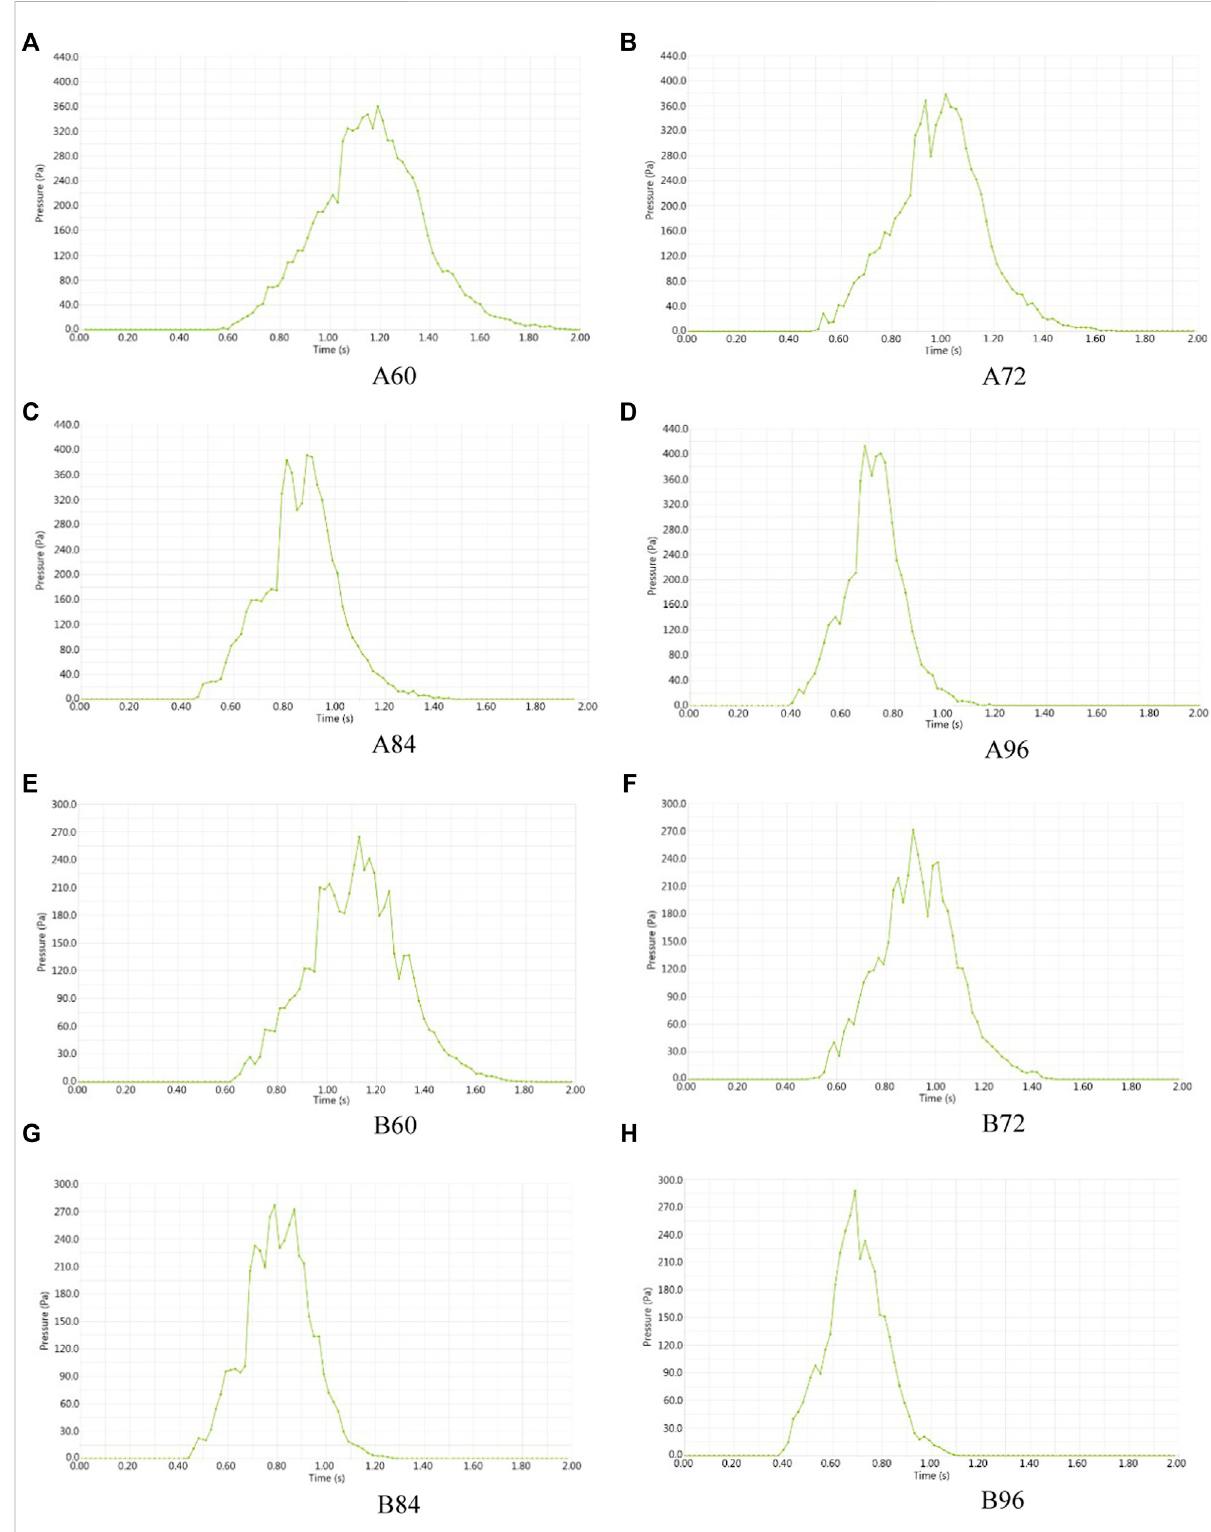
FIGURE 9 Curve of resistance variation of hanging cup